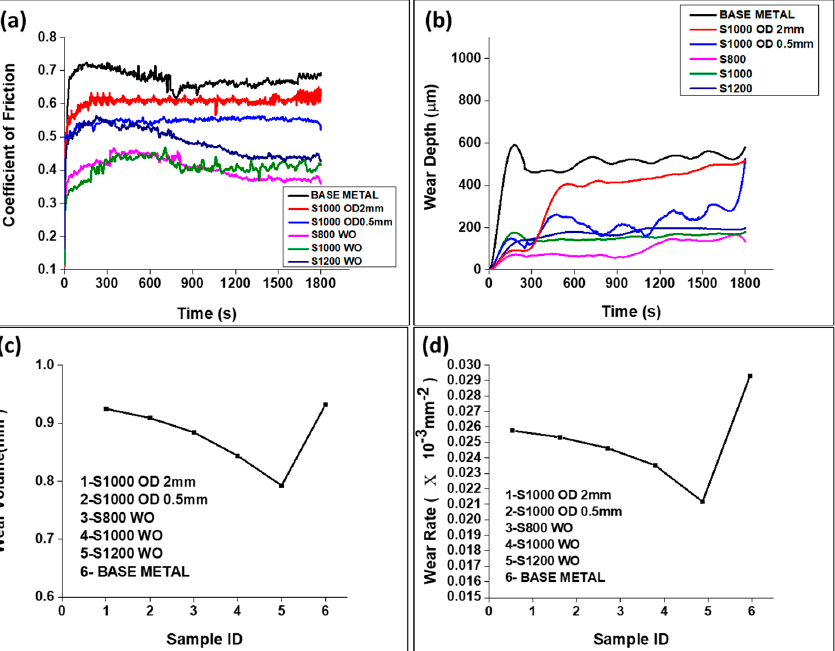
Figure 12. Wear test of EN25 steel for different sample conditions ( a ) COF vs. time, ( b ) wear depth vs. time, ( c ) wear volume vs. time and ( d ) wear rate vs. time, all for load 30 N track length 2 mm and frequency 10 Hz.